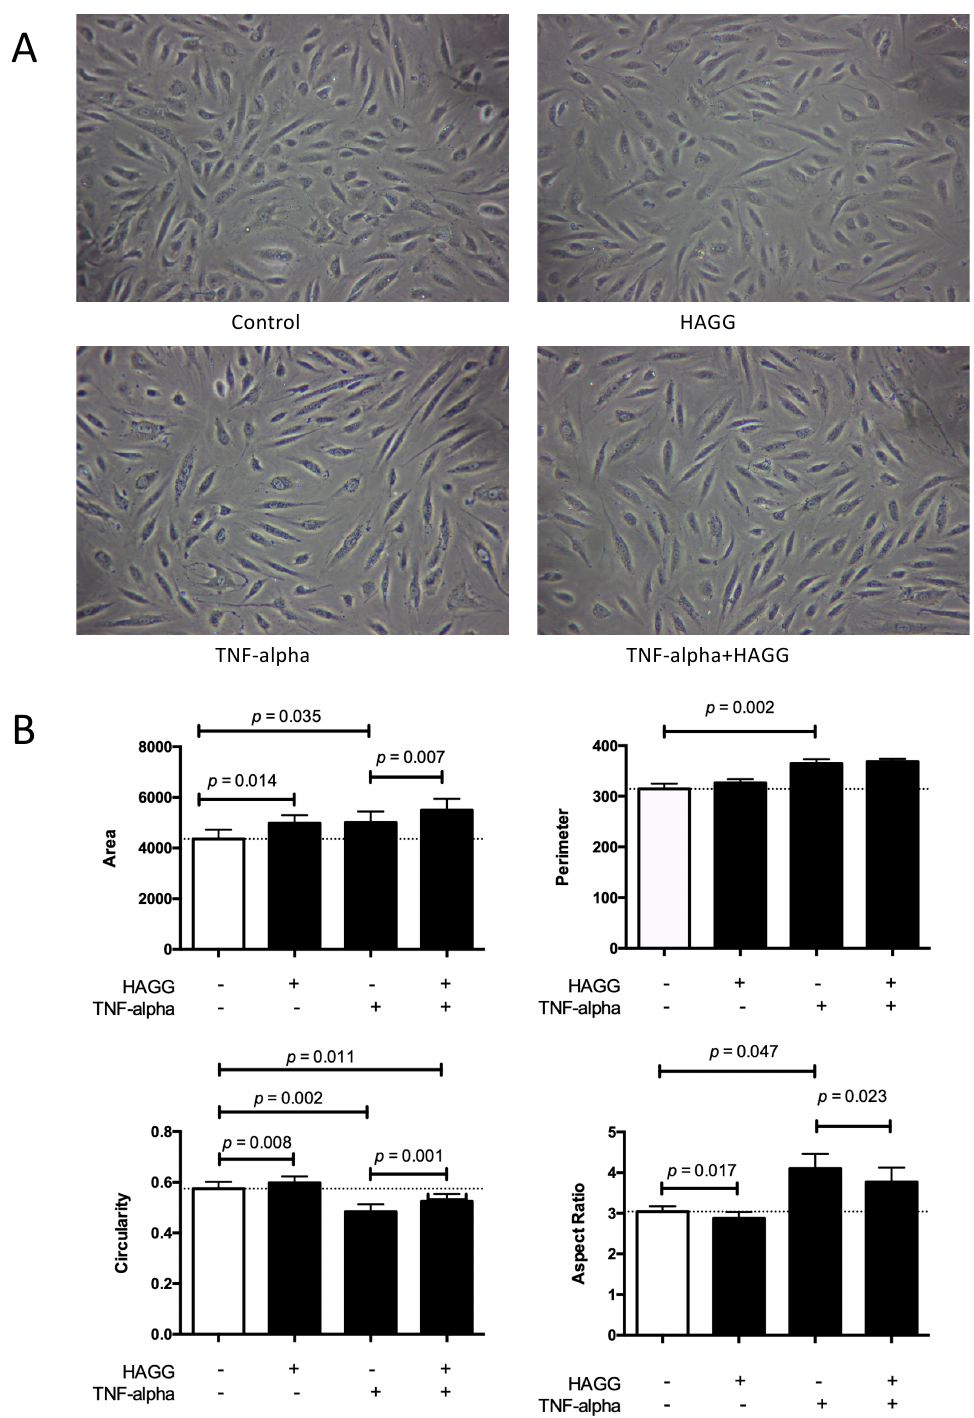
Figure 1. Cell morphology was changed after heat-aggregated gamma globulin (HAGG) treatment. Glomerular endothelial cells (GECs) were treated with complete medium (control), HAGG (400 µ g / mL), TNF- α (10 ng / mL), or TNF- α plus HAGG, respectively, for 8 h. ( A ) Representative photo micrographs of cells after 8-h incubation with di ff erent stimuli. Magnification: 100 times. ( B ) Statistical analysis of cell morphology parameters. Cell area, perimeter, circularity, and aspect ratio, were qualified by ImageJ software. Dotted lines indicated the mean values of the variables under control conditions. Data was presented as mean ± SEM ( n = 3). Paired t -tests were used to compare the groups under two di ff erent